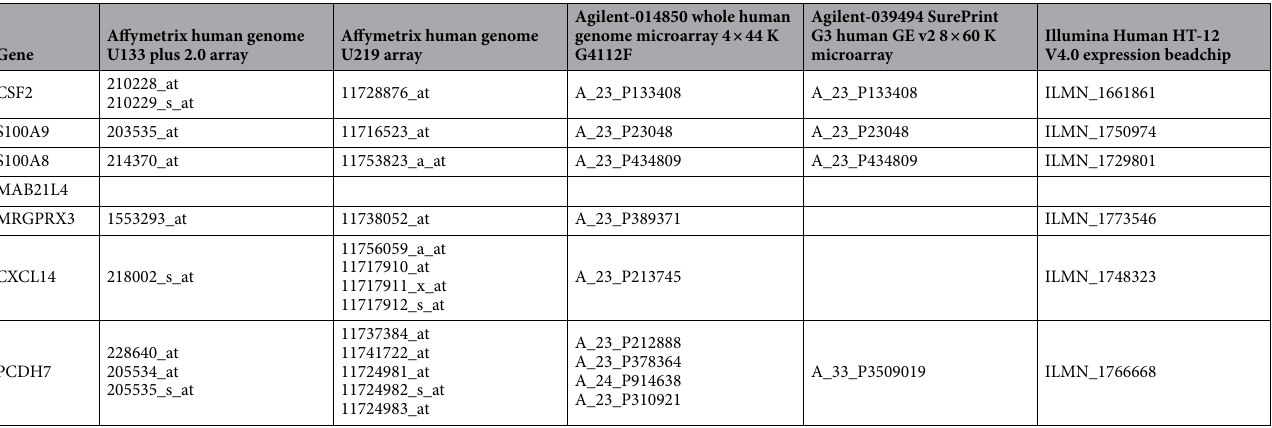
Table 1. List of probes associated with COVID-19 exclusive genes in microarray platforms related to selected gene expression